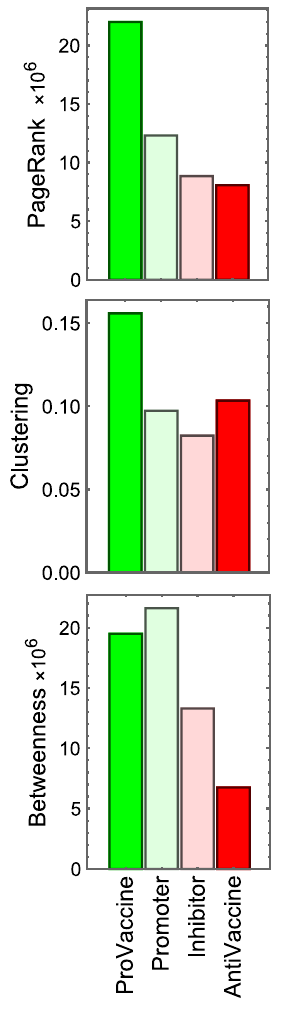
Figure 5. Bar charts displaying three standard network measures, averaged over all nodes in each category, within the complete network (also including non-classified nodes that interacted with the classified accounts). The top two charts show that pro-vaccine accounts have better quality connections (higher PageRank) but tend to form more triangular structures with nodes that also interact with each other (higher clustering coefficient), which is consistent with the overrepresentation of accounts of institutions and authorities in this category. The bottom chart shows the lower betweenness centrality of the inhibitor and anti-vaccine accounts, which can be interpreted as a positive diagnostic since it reflects their peripheral positions in the national